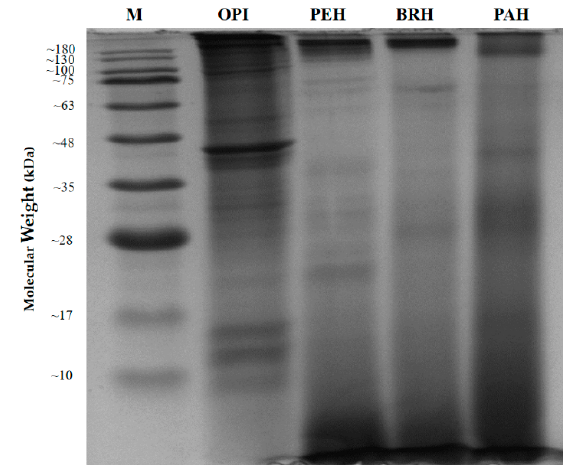
Figure 4. Peptide patterns of C. angulata protein hydrolysates by 15% SDS-PAGE. M: protein marker; OPI: oyster protein isolate; PEH: pepsin hydrolysate; BRH: bromelain hydrolysate; PAH: papain hydrolysate.